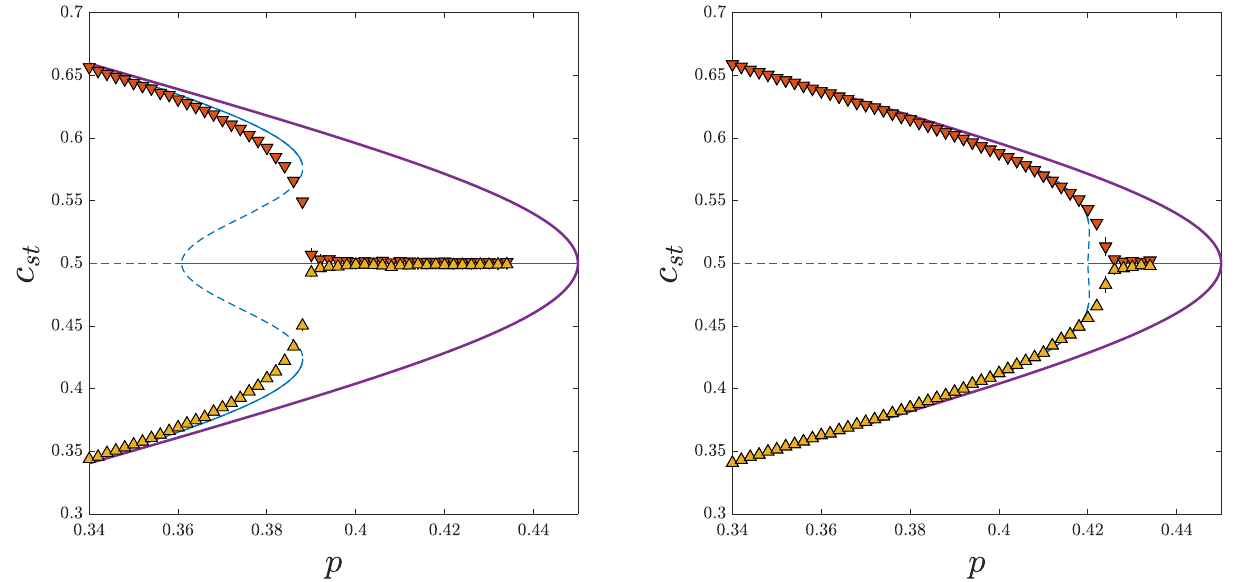
Figure 3. Dependence between the stationary concentration of up-spins c st and the probability of anticonformity p obtained within MFA (thick purple lines), PA (thin blue lines) and MC simulations (symbols) for q a = q c = q = 10 and : k = 50 (left panel), k = 150 (right panel). Solid lines denote stable and dashed lines unstable fixed points. Results from the initial concentration of up-spins c 0 = 1 are presented in the upper parts of the panels (orange down-pointing triangles), whereas for c 0 = 0.5 in the bottom parts (yellow up-pointing triangles). Black vertical error bars represent the standard deviation of stationary concentration. They are visible only near the critical point and for all other values they are smaller than the size of the